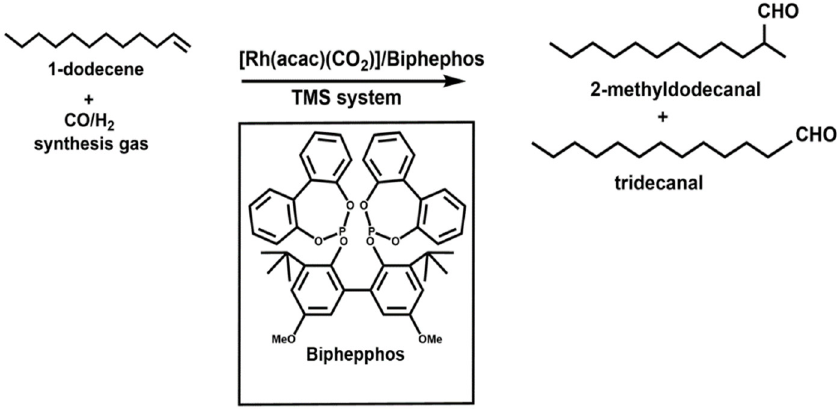
Figure 5. The hydrotormylation of 1-dodecene [70].